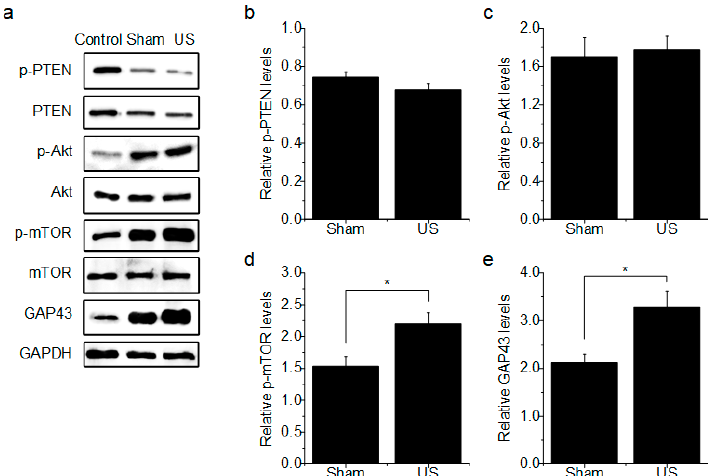
Figure 4. Protein expression of phosphatase and tensin homolog (PTEN), protein kinase B (Akt), mammalian target of rapamycin (mTOR), and growth-associated protein-43 (GAP-P43) in axotomized DRG explants. ( a ) Representative Western blot image. ( b ) Relative p-PTEN levels in the sham and US groups ( n = 3). ( c ) Relative p-Akt levels in the sham and US groups ( n = 3). ( d ) Relative p-mTOR levels in the sham and US groups ( n = 3). ( e ) Relative GAP-43 levels in the sham and US groups ( n = 3). The data are presented as the mean ± SEM; * p < 0.05.